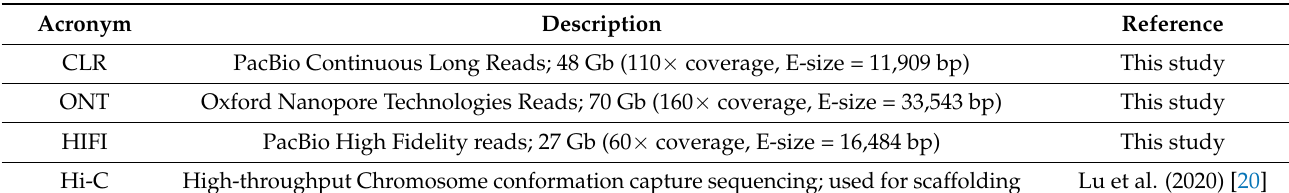
Table 1. Sequence datasets analyzed in this study.